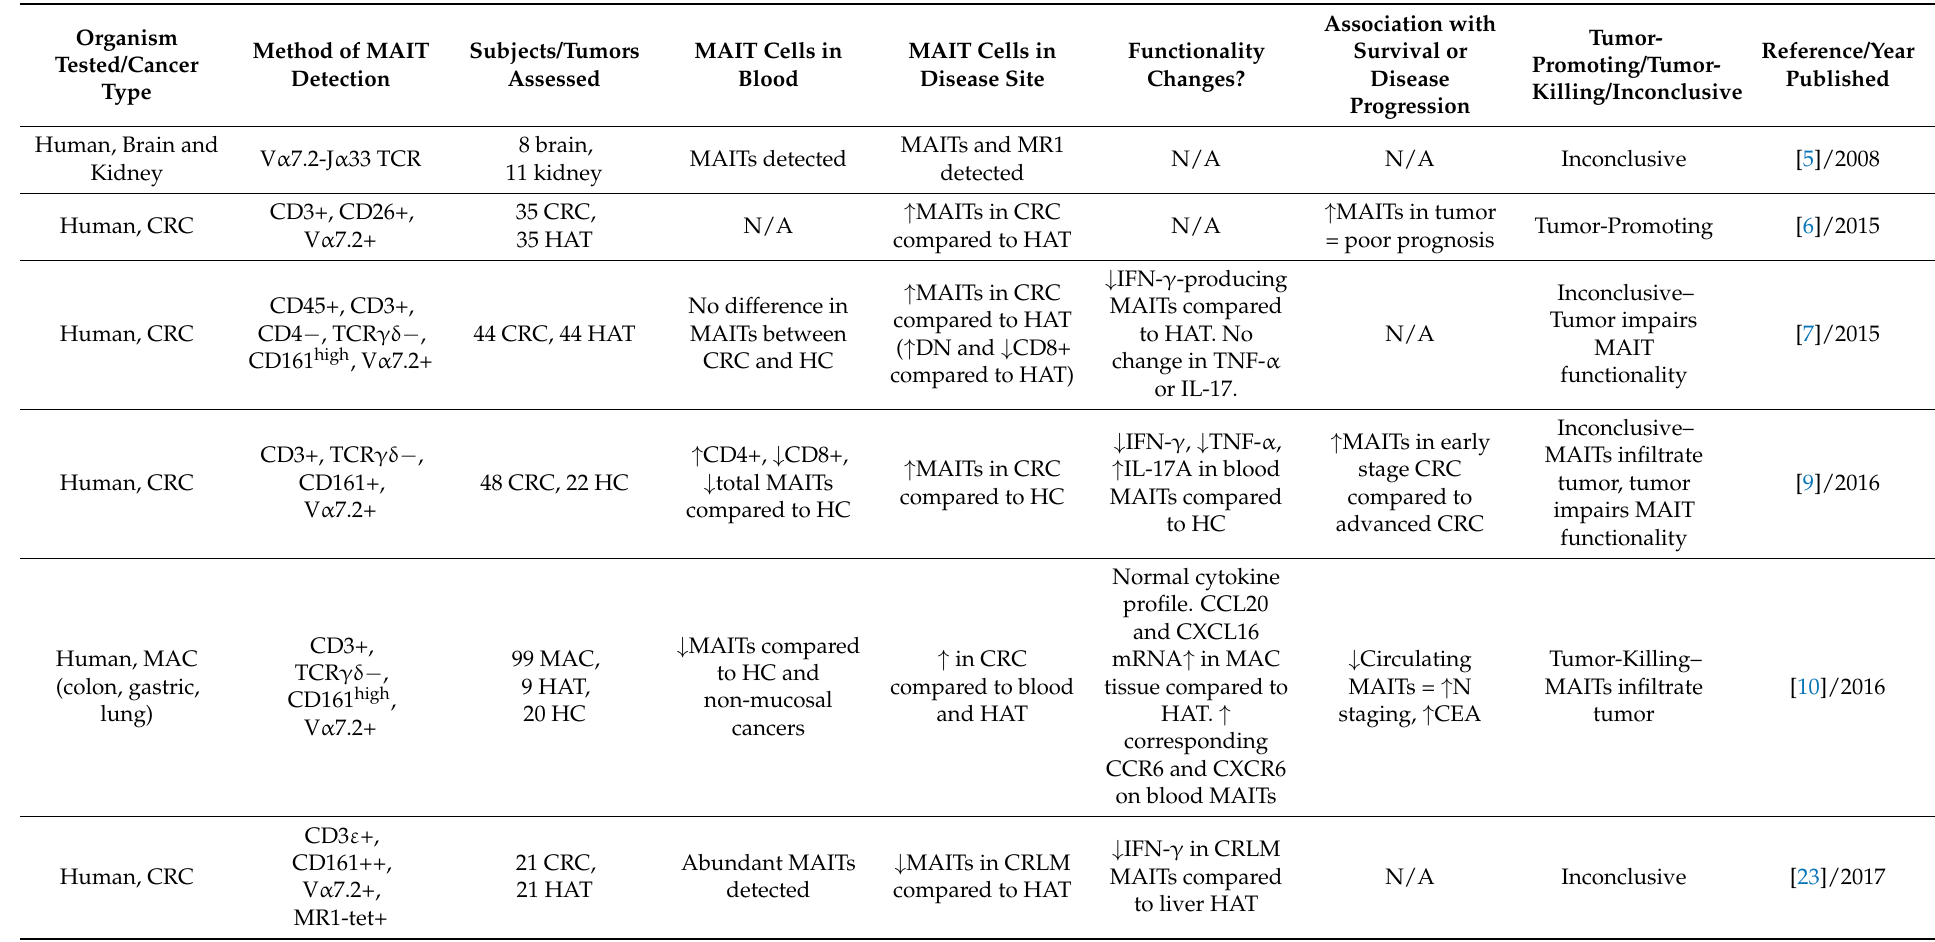
Table 1. Summary of ex vivo